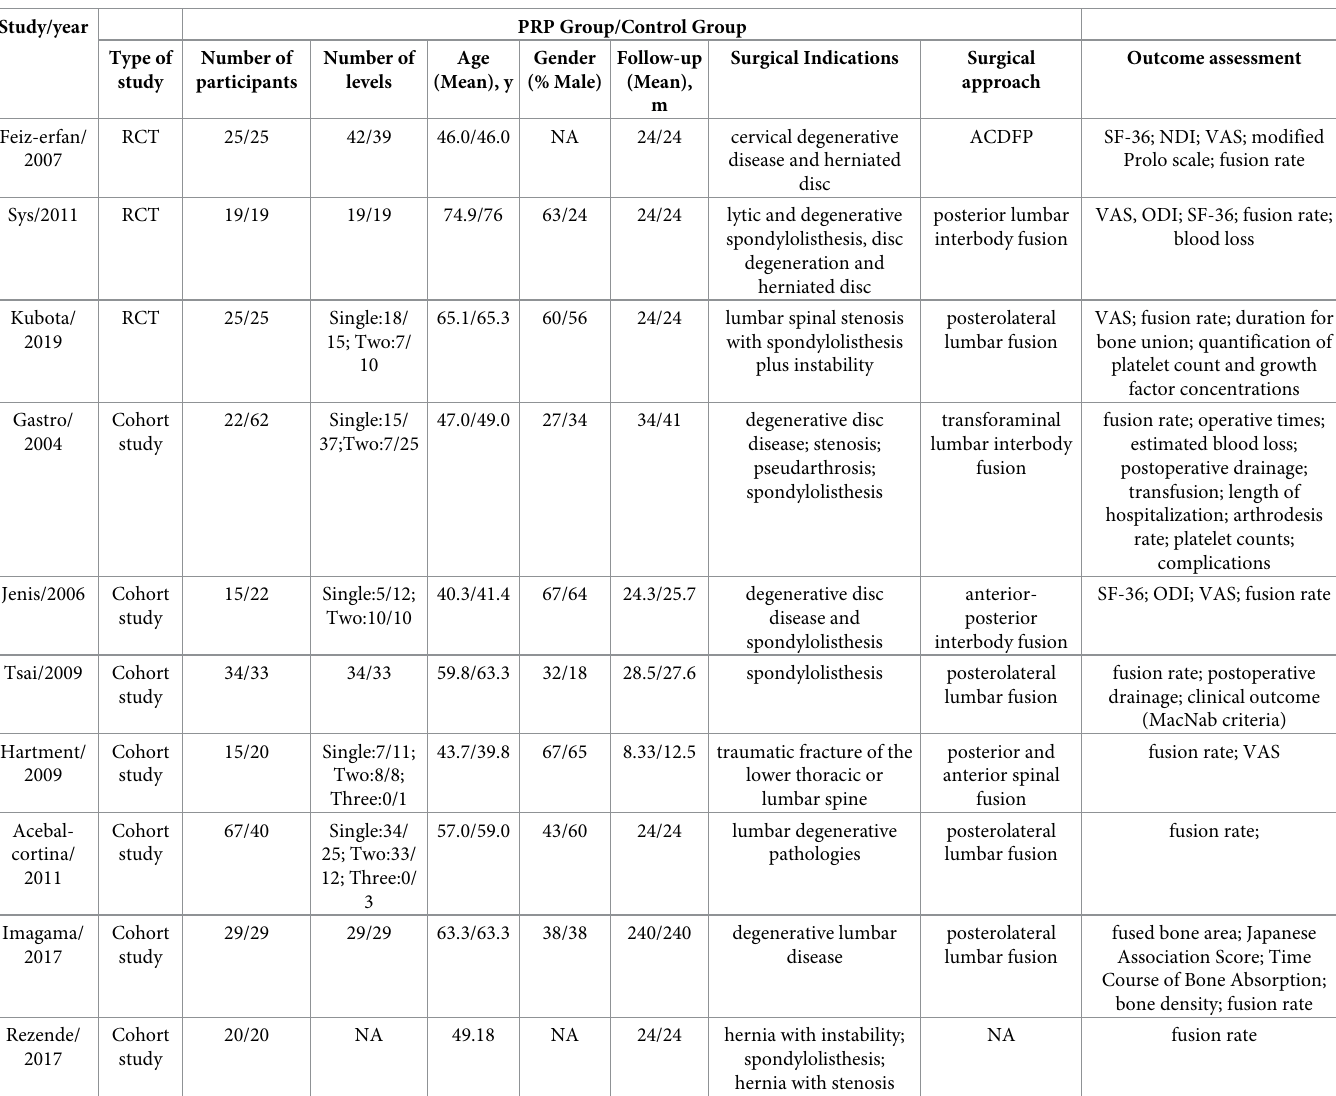
Table 1. Characteristics of included